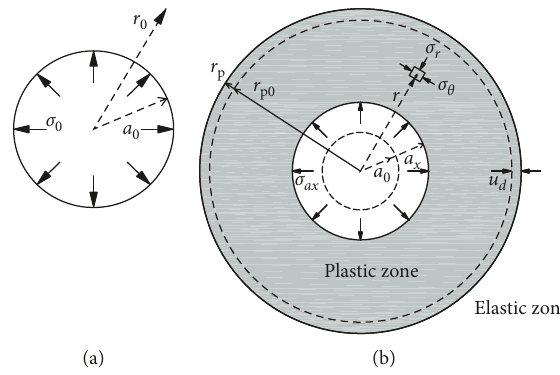
Figure 2: Schematic diagram of cavity expansion. (a) Cavity before expansion. (b) Cavity in